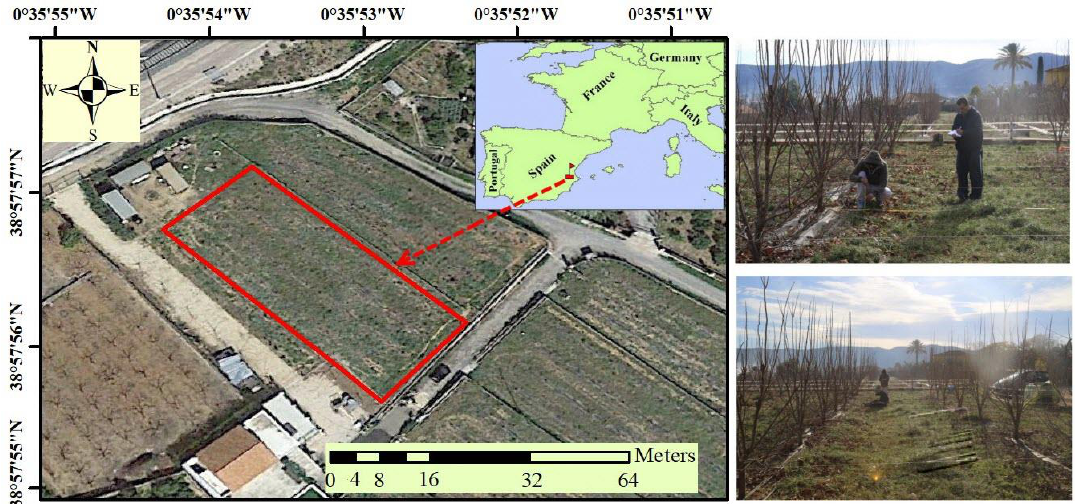
Figure 1. View of the studied agricultural terrace and location of the study site.